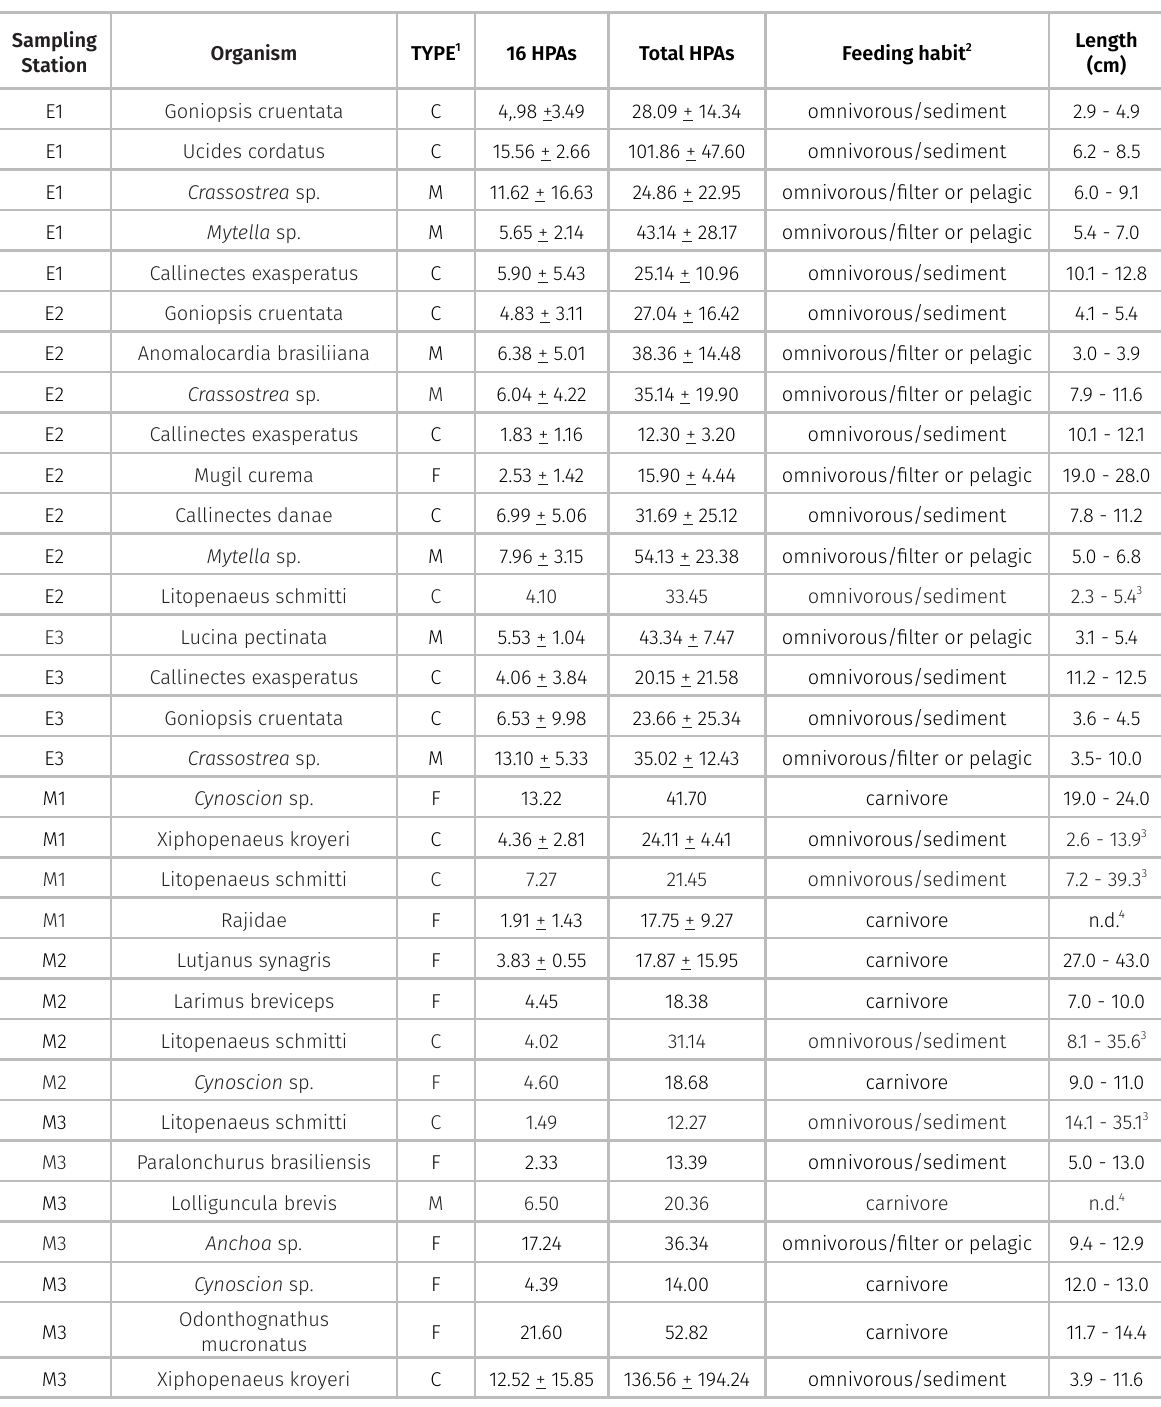
Table I. PAH concentrations, in ng g -1 , feeding habit and size (length) of organisms collected in the Canavieiras region after the 2019 oil spill in the Brazilian